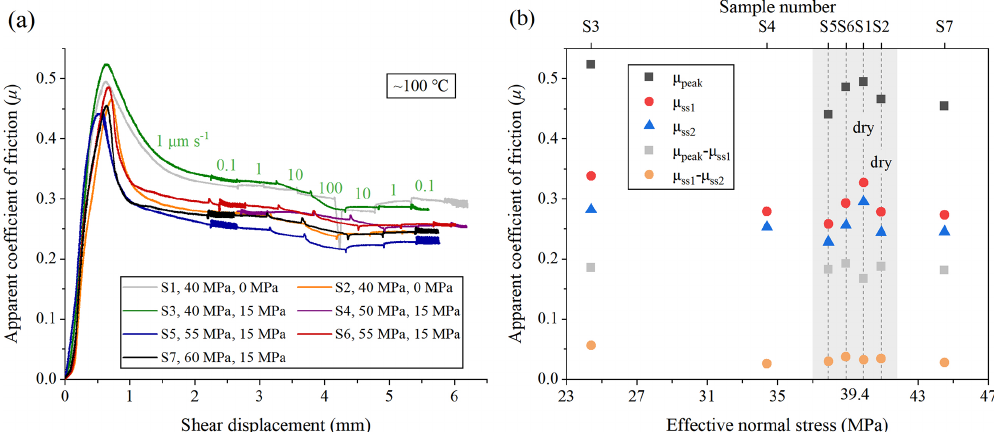
Figure 3. Frictional properties of samples S1–S7 obtained from the velocity stepping experiments. (a) Apparent coefficient of friction ( µ ) against shear displacement. (b) Apparent coefficient of friction ( µ ) against effective normal stress. Note that the data offset is given in the grey area; i.e., the data plotted on the vertical dashed lines were all obtained at ∼ 40MPa effective normal stress but are horizontally offset here for